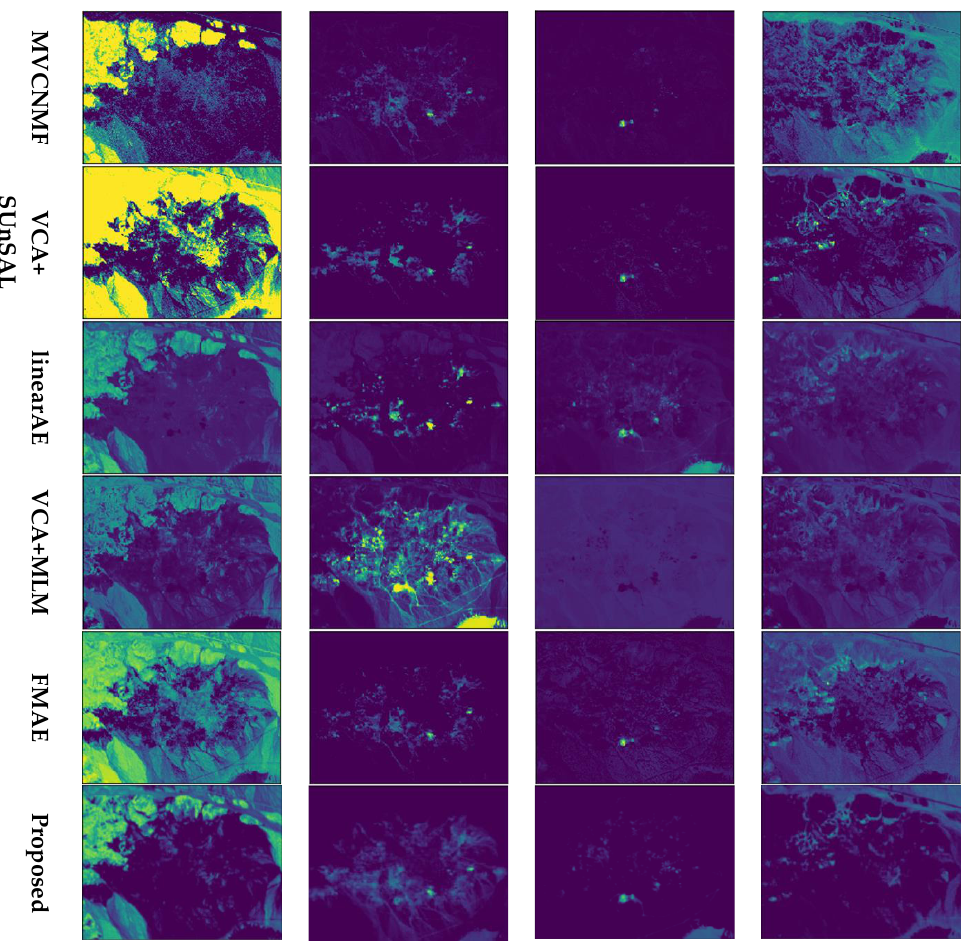
Figure 16. Estimated abundance maps for cuprite. The corresponding materials from left to right are: sphere, dumortierite, buddingtonite and nontronite. From top to bottom for different methods.